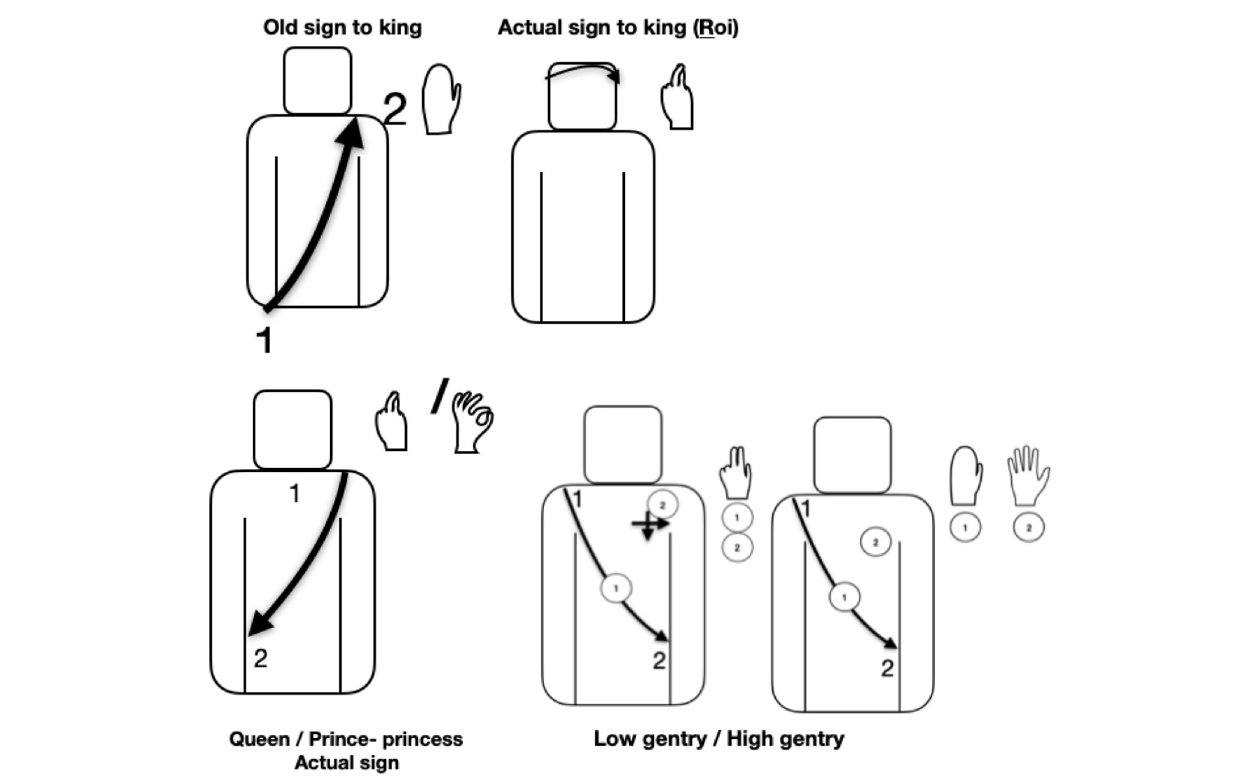
FIGURE 1 | On the signs of French Gentry in eighteenth century. This sign of king, actually forgotten, was discovered in a French sign language dictionary of 1873. This joins the originel Desloges’ description of sign on the signs to designate the gentry scarf. The sash is the typical representation of the gentry in the eighteenth century (see the example of the picture of Louis de Bourbon-Conde (Link: https://upload.wikimedia.org/Wikipedia/commons/d/db/Louis_Joseph_de_Bourbon_ Prince_of_Conde.jpg). Every member of the gentry, women and men, have a scarf and a cross on the heart. That is why Desloges describes the signs of the nobility in two different signs, one for the high gentry (linked with the King, or in the monarchy government,) and the low gentry, more local and less powers He described it in his book Observations d’un sourd et muet , published in 1779. These examples of the signes are the best to understand the place of the deafs In the society in seventeenth and eighteenth centuries. These signs show us their representation of this society by the visual